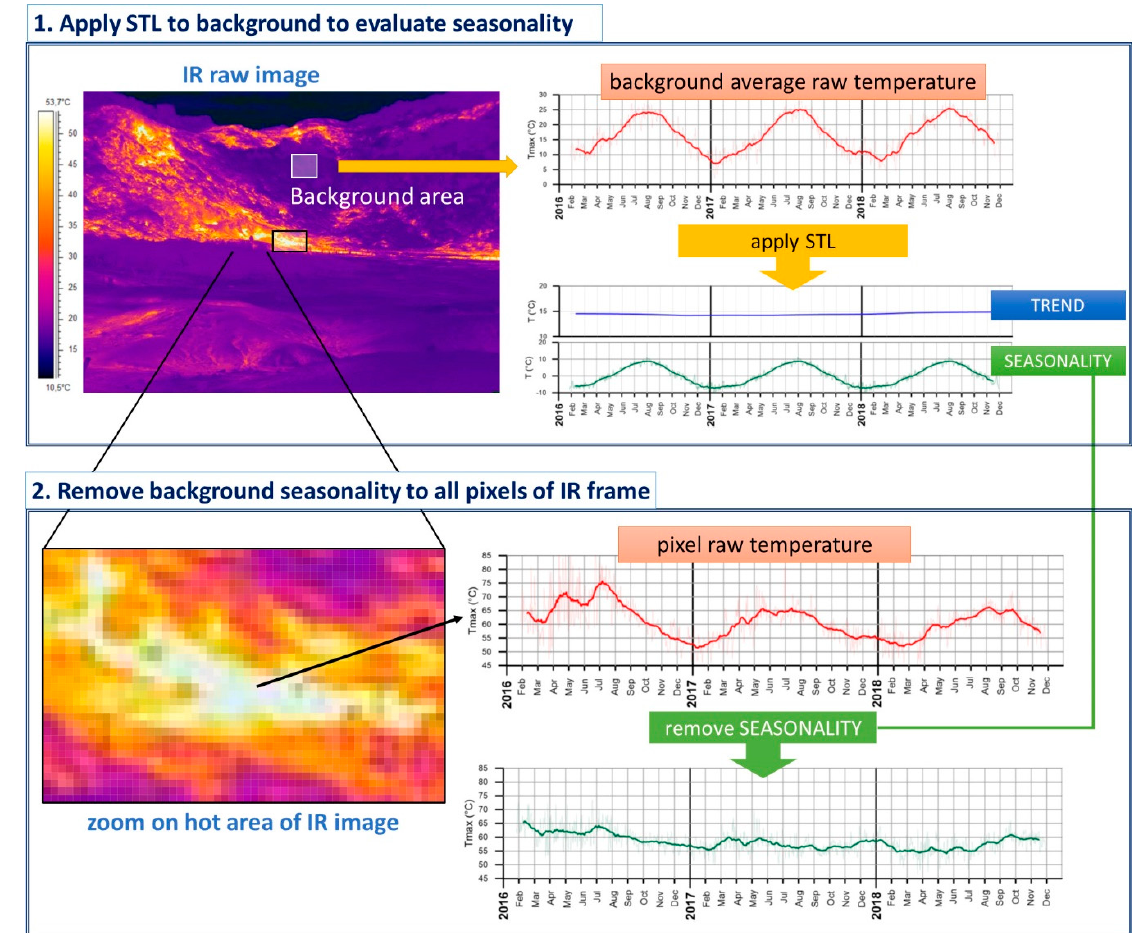
Figure 6. Processing scheme used to remove seasonal component of TIRNet data by using R script including STL procedure (‘STLIR.R’) and Matlab code. 1) Evaluation of seasonal component (S) by applying STL to background area. 2) Removal of S to a pixel raw temperature in order to get the de-seasoned values.